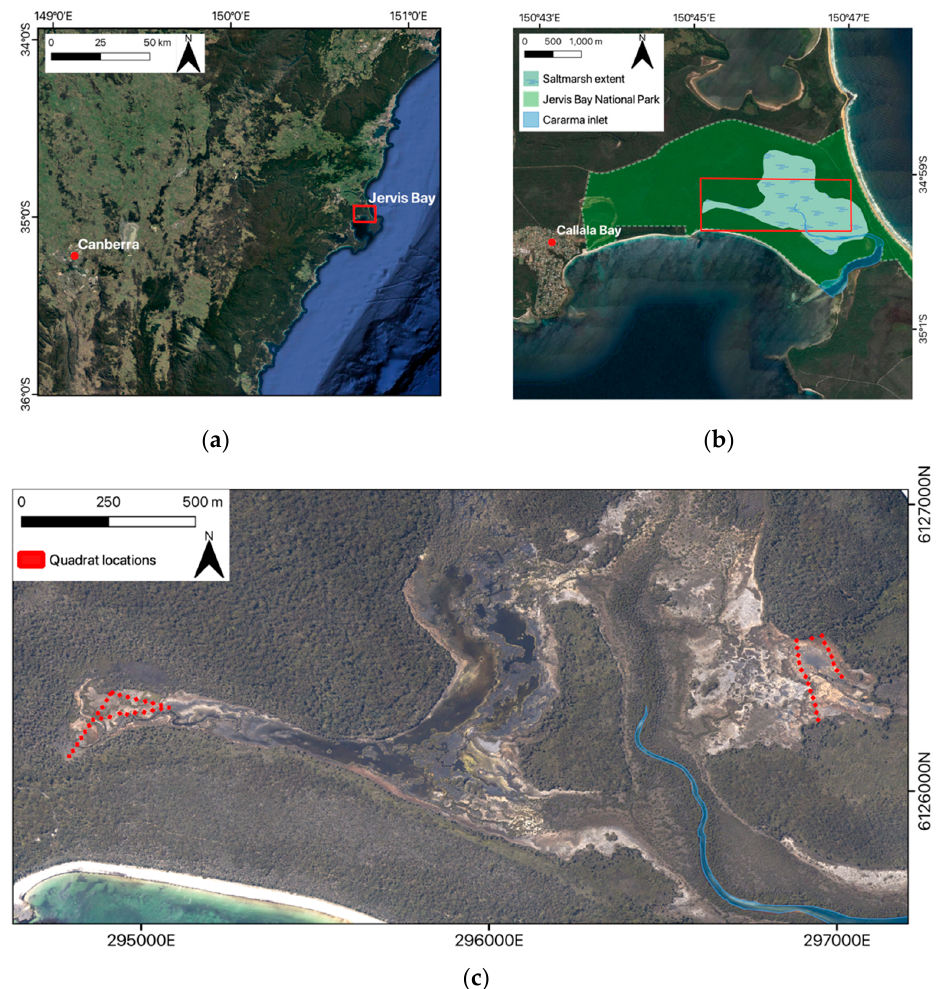
Figure 1. ( a ) Jervis Bay National Park is located 150 km east of Canberra; ( b ) The areal extent of the saltmarsh study located along the upper reaches of Cararma Inlet; ( c ) The 1 m 2 vegetation quadrats overlayed on the ArborCam true colour orthoimage.